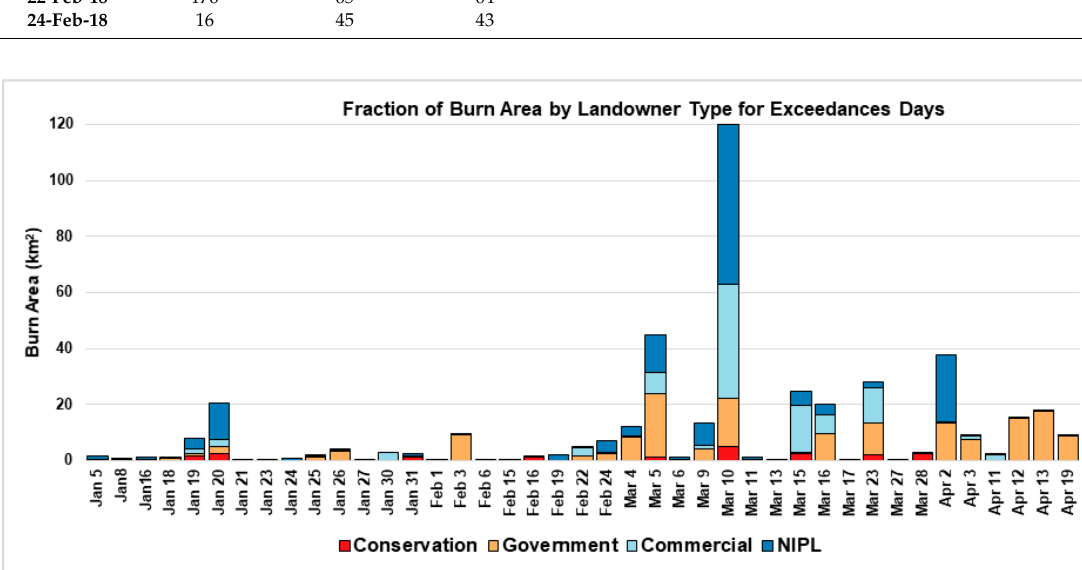
Figure 1. PM 2.5 exceedance days in Georgia for 24-hour National Ambient Air Quality Standard (NAAQS) (1 January − 30 April 2018), along with permitted burn area (Km 2 ) categorized by landowner type. Burn area corresponds to the total burn area within a 20 km radius from the exceedance location, within 48 hours from the time of